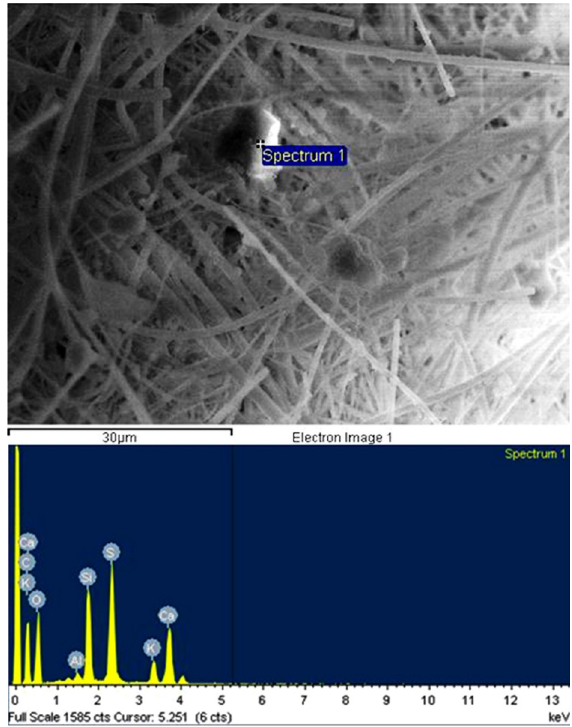
Figure 9. SEM micrograph and EDS spectrum of spongiform spherical particles.